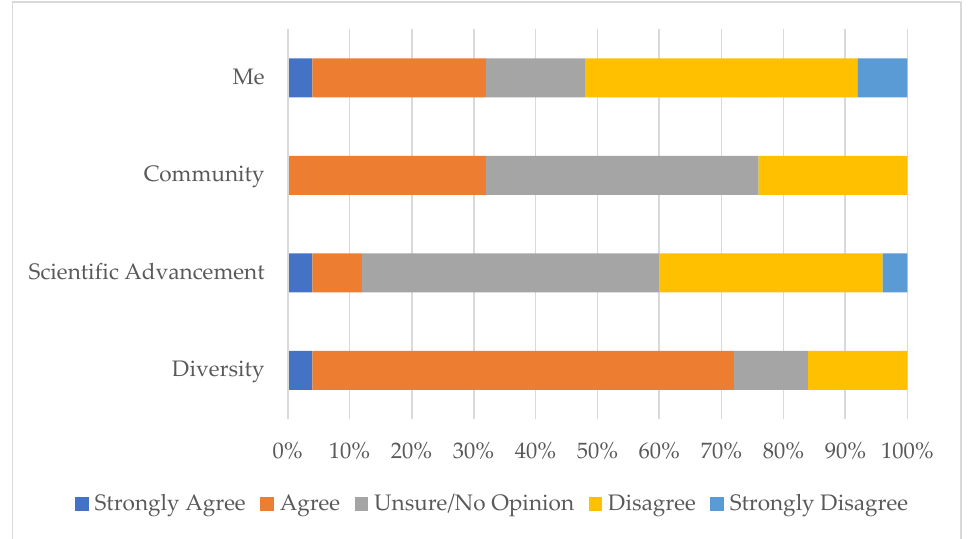
Figure 2. Participant agreement with the statement that online conferences are better for diversity, scientific advancement, the community, or themselves.